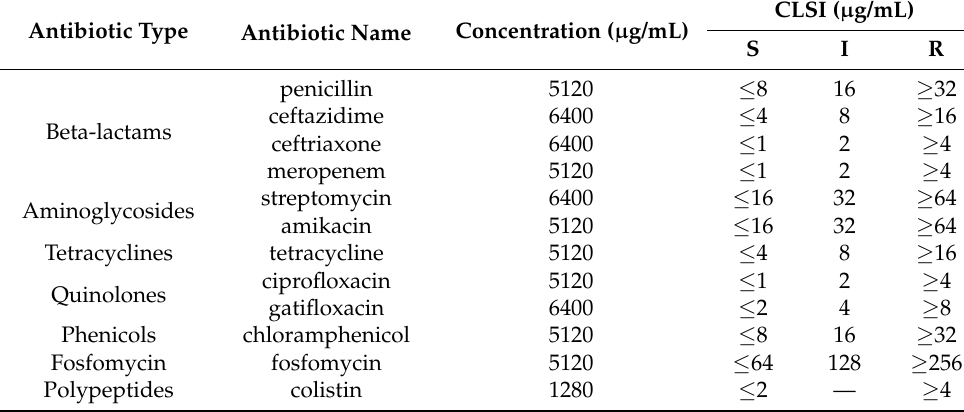
Table 2. Judgment table of resistance break point of tested antibacterial